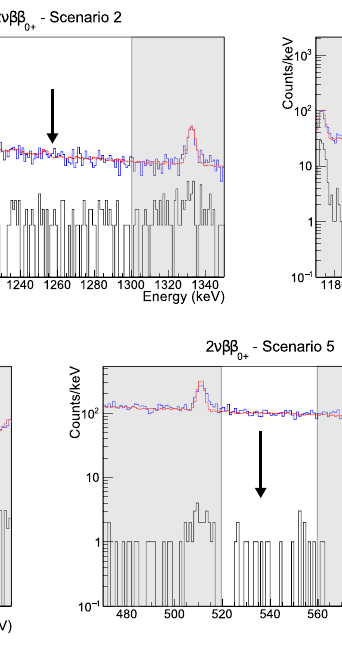
Fig. 2 CUORE-0 spectra for the five signatures selected for the 0 νββ decay. The blue histogram shows the data without any energy- 0 + 1 related cut; the reconstruction of the background model is shown in red;